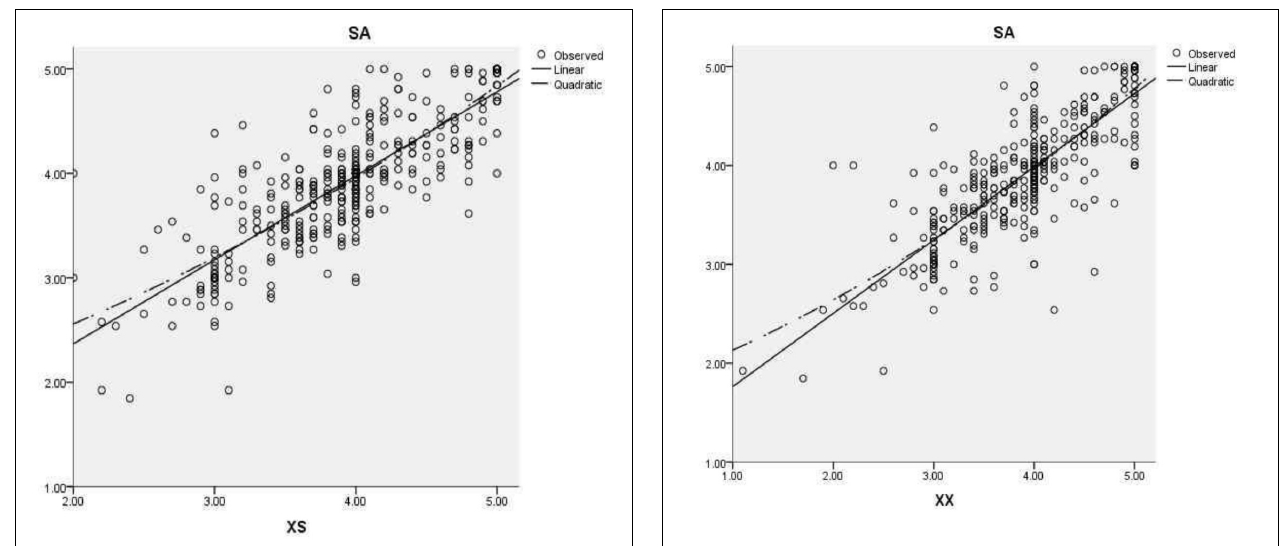
FIGURE 3 | Linear and curve fitting diagram of school management factors (XX) to overall satisfaction (SA).